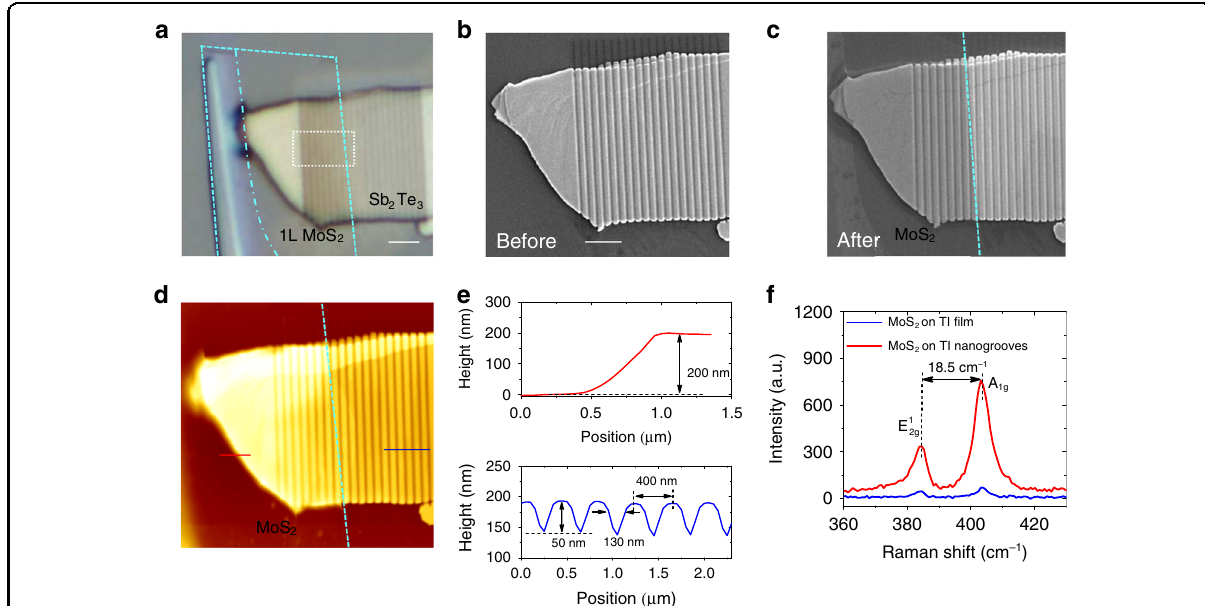
Fig. 4 Structure and material characterization of the monolayer MoS 2 /Sb 2 Te 3 nanogroove heterostructure. a Optical microscope image of Sb 2 Te 3 nanogrooves with a transferred MoS 2 layer. The area marked by the cyan dashed line denotes the MoS 2 layer. The area on the right side of the dashed-dotted line represents monolayer (1 L) MoS 2 . The scale bar is 2 μ m. b , c SEM images of Sb 2 Te 3 nanogrooves before and after transferring MoS 2 . The scale bar is 2 μ m in b . d AFM image of Sb 2 Te 3 nanogrooves with MoS 2 . e AFM-measured height pro fi les of the Sb 2 Te 3 fi lm and nanogrooves at the positions along the red and blue lines in d . f Raman spectra of the MoS 2 layer on the Sb 2 Te 3 TI fi lm and nanogrooves excited with the 532 nm laser when θ =